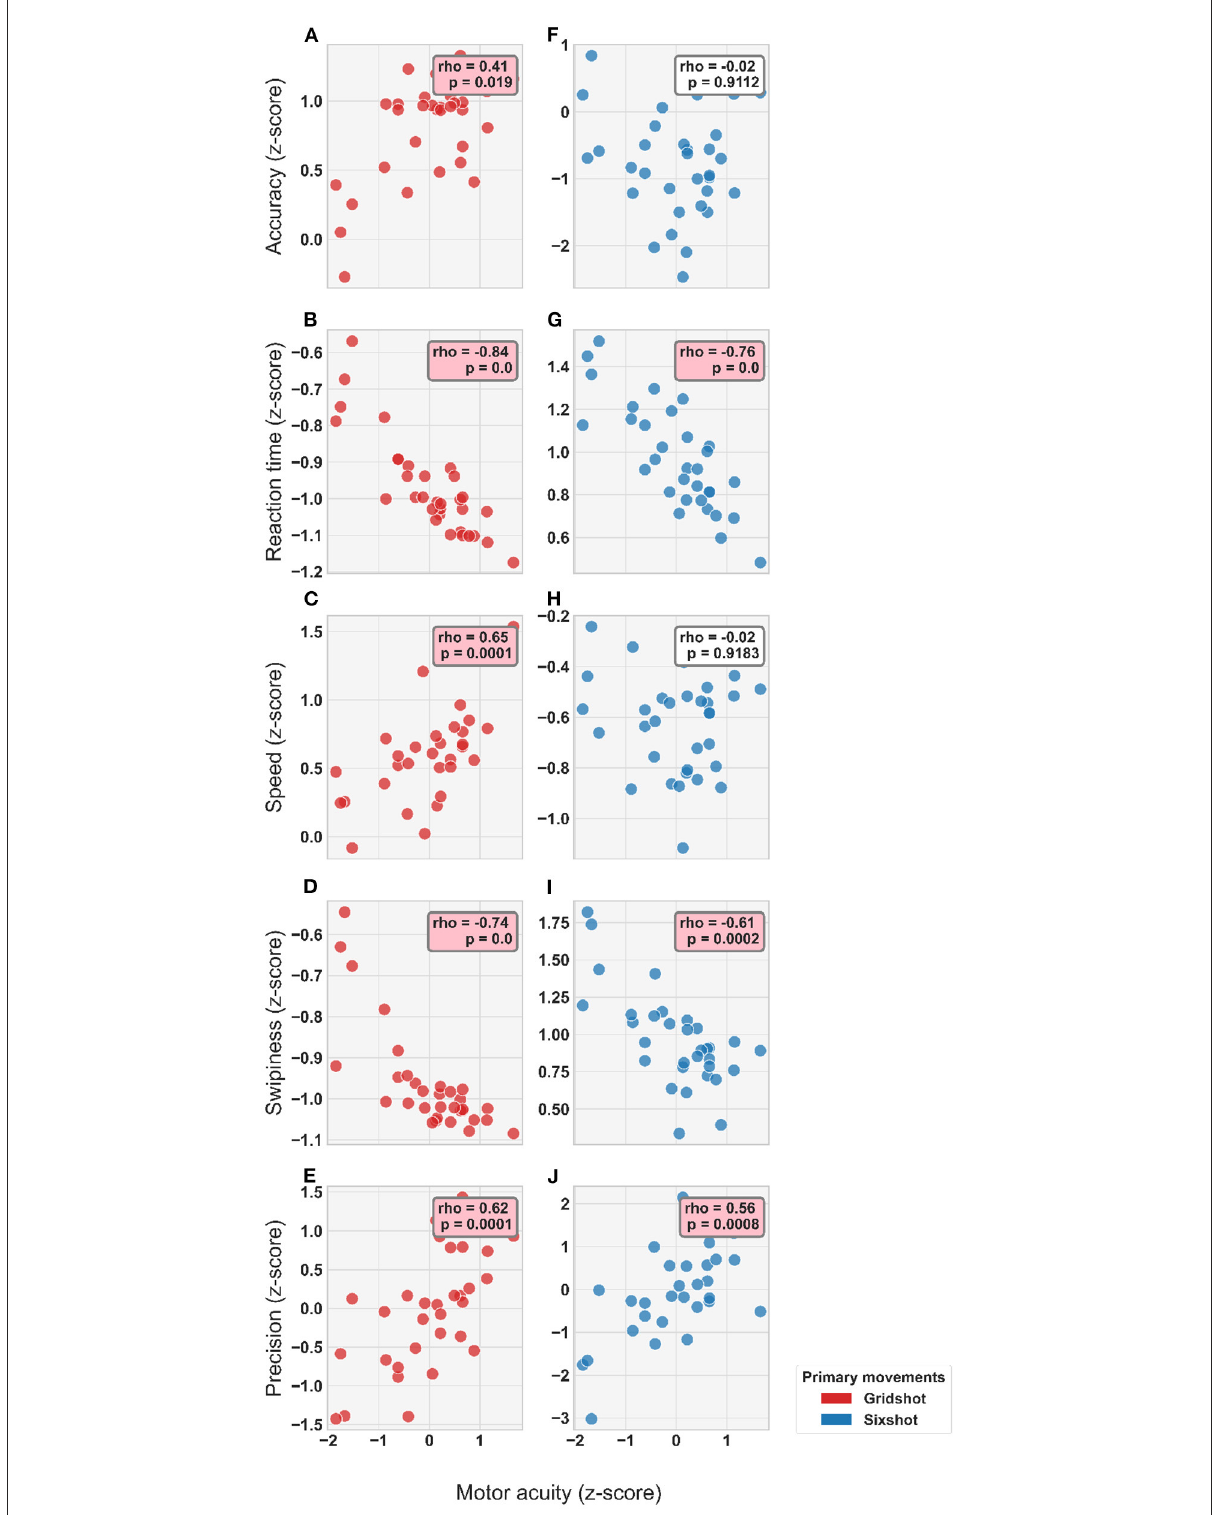
FIGURE7 Correlation between player kinematics and motor acuity for each metric in each task (see Legend): (A–E) Gridshot. (F–J) Sixshot. Statistical results from Spearman’s Rank Correlation displayed in annotation boxes; where rho, Spearman’s Correlation Coefficient and P, p -value. Pink annotation boxes indicate a p <